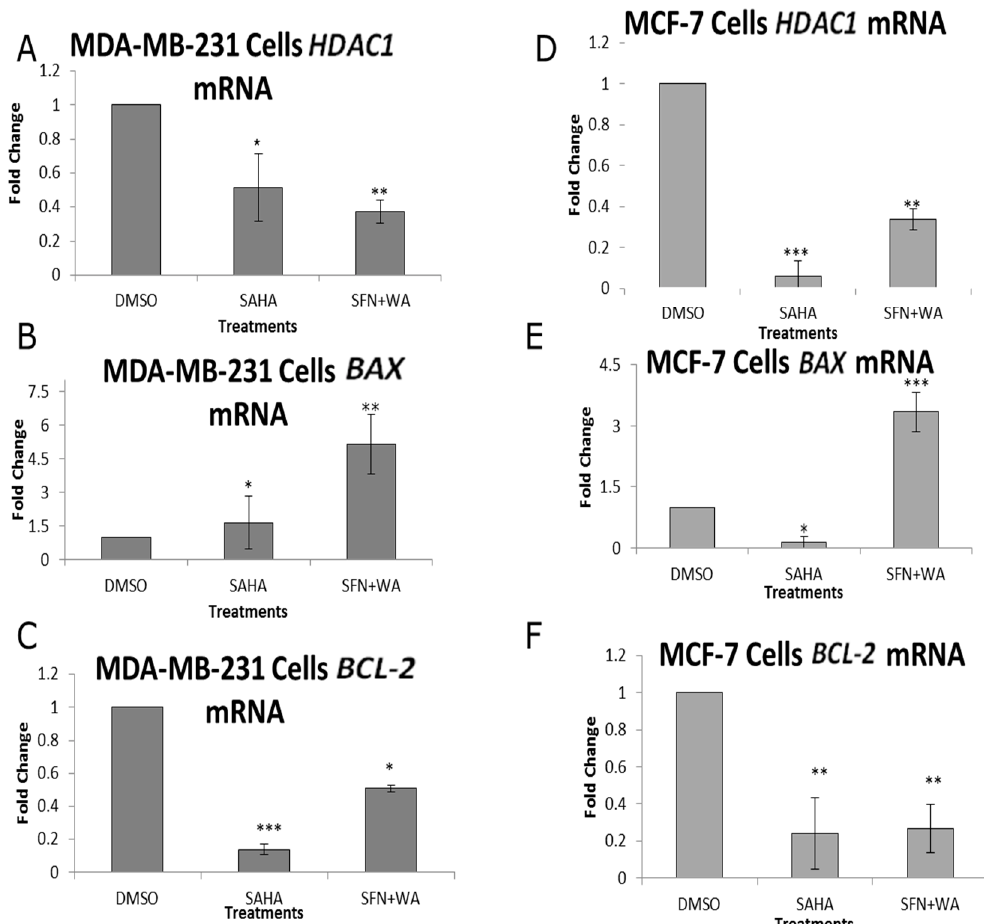
Figure 9. Suberoylanilide hydroxamic acid (SAHA) and combinatorial SFN + WA promote changes in apoptotic genes at the mRNA level. ( A ) qRT-PCR was used to determine the mRNA expression of HDAC1 in MDA-MB-231 triple-negative breast cancer cells in comparison to the 3.0 µM optimal concentration of SAHA. SFN and WA concentrations are 5.0 and 1.0 µM respectively; ( B ) mRNA expression of the pro-apoptotic BAX is shown in MDA-MB-231 cells; ( C ) qRT-PCR shows the expression of the anti-apoptotic BCL-2 in MDA-MB-231 cells; ( D ) HDAC1 mRNA expression in MCF-7 cells shows changes with the incorporation of the chosen compounds; ( E ) mRNA expression of the pro-apoptotic gene BAX is upregulated by combinatorial SFN and WA; ( F ) The anti-apoptotic gene BCL-2 shows a downward progression in MCF-7 cells with the incorporation of the indicated drugs and compounds ( n = 3: SEM, * p < 0.05, ** p < 0.01, *** p < 0.001). SEM: standard error of mean.